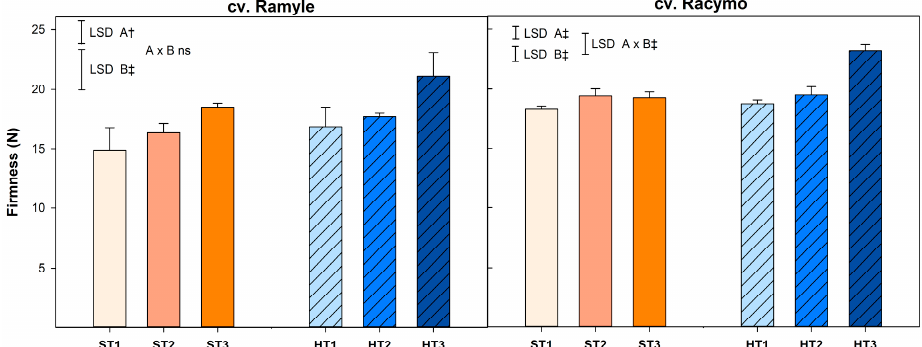
Figure 3. Firmness of two tomatoes (cvs. Ramyle and cv. Racymo) under di ff erent irrigation treatments (T1: desalinated seawater with low electrical conductivity (EC); T2: well / desalinated water, intermediate EC; and T3: well water with high EC) and cultivation systems (traditional soil system, S; hydroponic, H) ( n = 3 ± SD). The uppercase letters A and B denote cultivation system and irrigation treatment, respectively. ns, † , and ‡ significance for p ≤ not significant, 0.01, and 0.001, respectively.